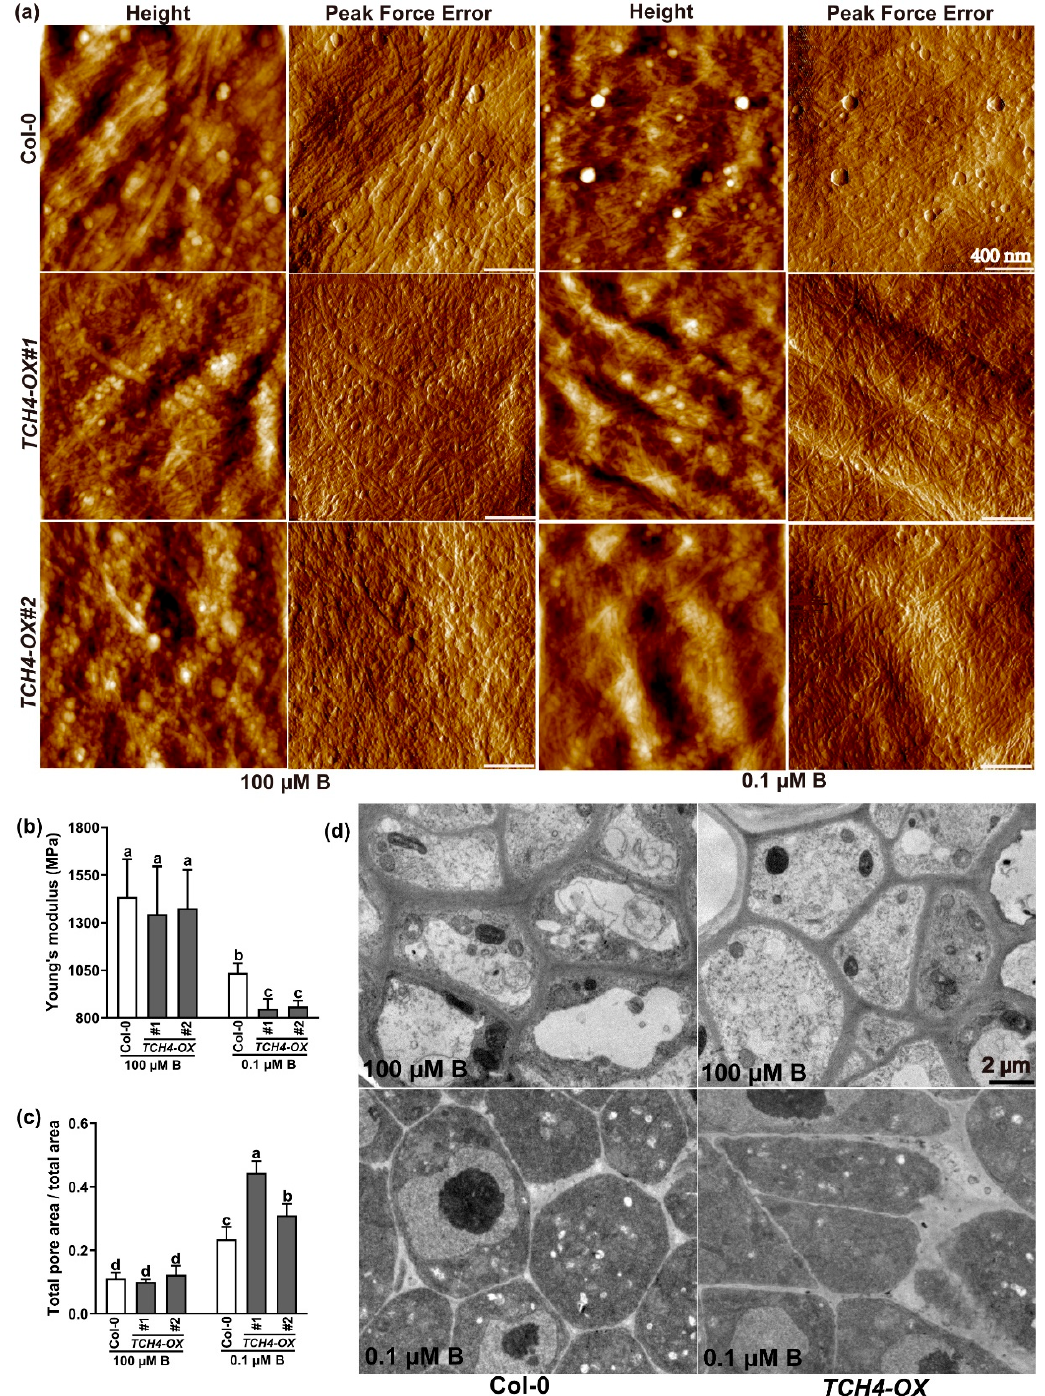
Figure 8. Cell wall characteristics of Col-0 and TCH4 - OX lines in roots. The plants were grown in media consisting of 100 μ M B and 0.1 μ M B for 10 d. ( a ) Atomic force microscopy (AFM) revealing the cell wall’s surface characteristics and topography of the Col-0 and TCH4 - OX lines in roots. The height and peak force error images are presented. Scale bar, 400 nm. ( b , c ) Young’s modulus ( b ) and the ratio of total pore area versus the total area were measured ( c ). The different letters above the columns indicate significant differences between all genotypes and all growth conditions ( p ≤ 0.05). ( d ) Transmission electron microscopy (TEM) analysis of root meristem cells. Scale bar, 2 μ m.